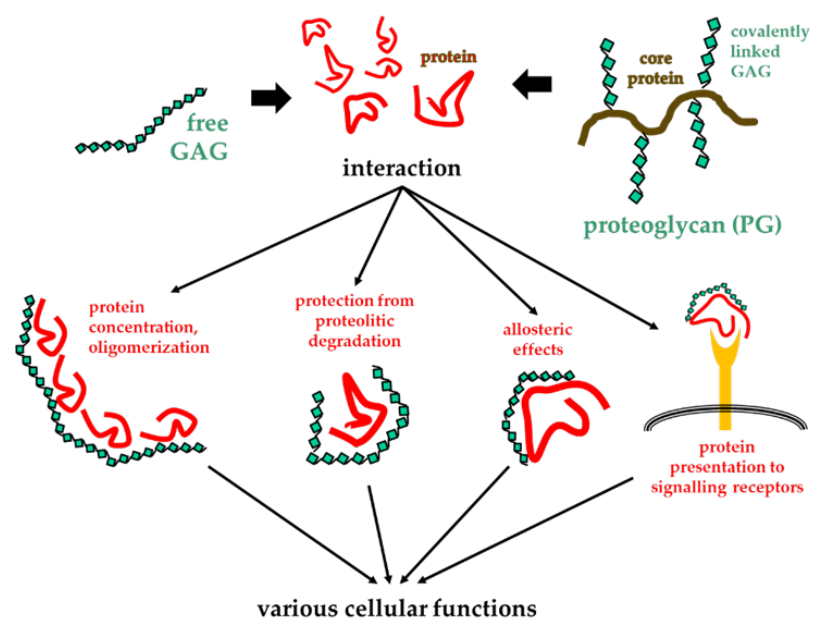
Figure 2. Consequences of GAG/PG interactions with proteins. Upon their binding, GAGs/PGs exert different effects on proteins that impact various cellular functions.